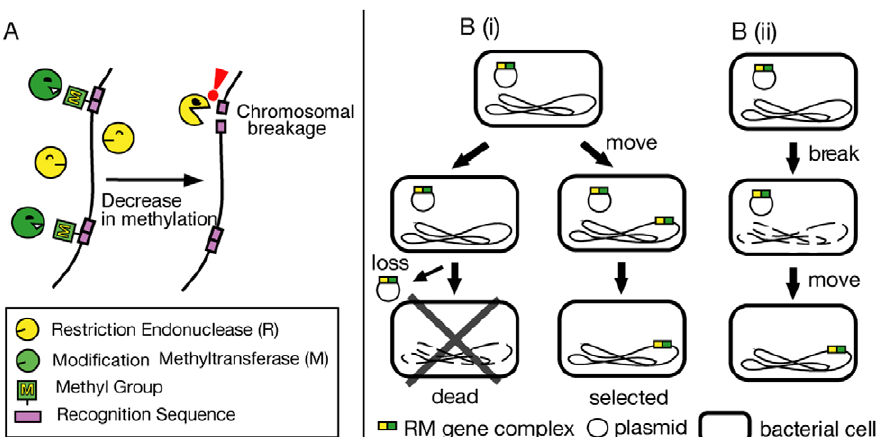
Figure 1. Probable actions of restriction-modification (RM) systems. A. Post-segregational killing. Loss or disturbance of an RM system leads to chromosomal breakage by the R enzyme and, unless repaired, to cell death. B. Two possible roles of R in the successful movement. (i) Selection. The RM system on a plasmid moves to a new locus in the genome. The cells with the unrearranged genome are killed by RM attack after the plasmid loss, while the cells carrying the chromosome into which RM is incorporated would survive. (ii) Movement. RM-mediated DNA breakage promotes movement.